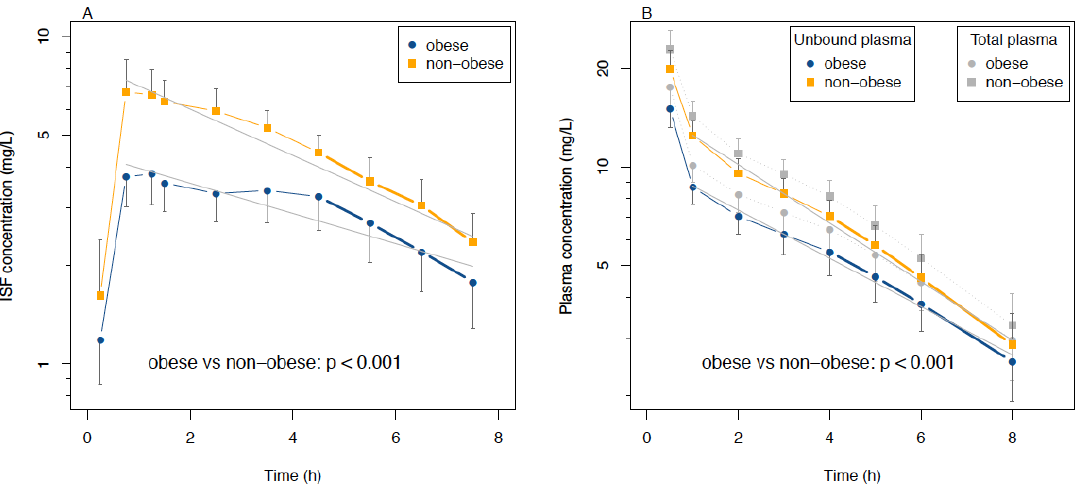
Figure 3. Concentration–time curves of linezolid ( A ) in interstitial fluid of subcutaneous adipose tissue (ISF) and ( B ) in plasma (total and unbound) after single administration of 600 mg linezolid intravenously. Whiskers indicate a 95% CI. The linear mixed-model was visualized by the solid (obese) and dashed lines (non-obese) of concentrations in ISF (Figure 3A) or unbound concentrations in plasma (Figure 3B) and formed the basis for the formal statistical comparison of the obese vs. non-obese groups. Note that half-lives were estimated by linear regression using the last 4–5 points in the curves and are not represented by the lines in the figure.